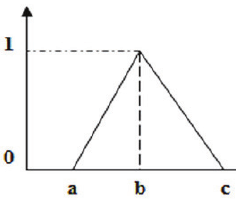
Fig. 8. A triangular fuzzy number, M